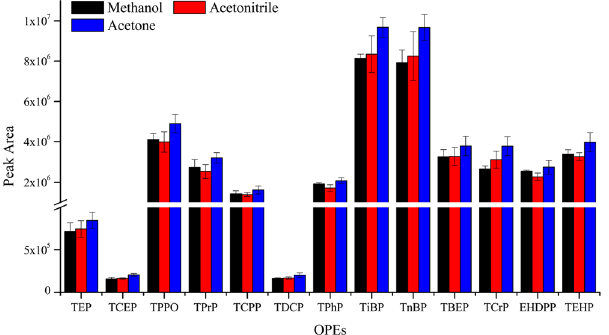
Figure 7. The efficiency of different demulsifiers on the extraction of OPEs from aqueous samples (n = 3).